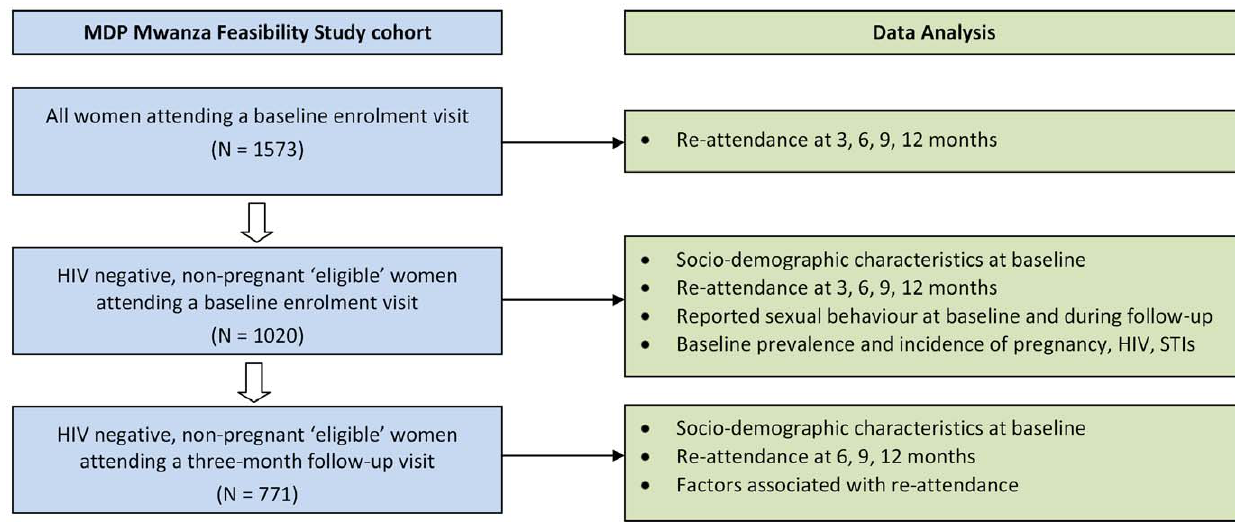
Figure 1. Data analysis summary by sub-cohort, MDP Mwanza Feasibility Study.